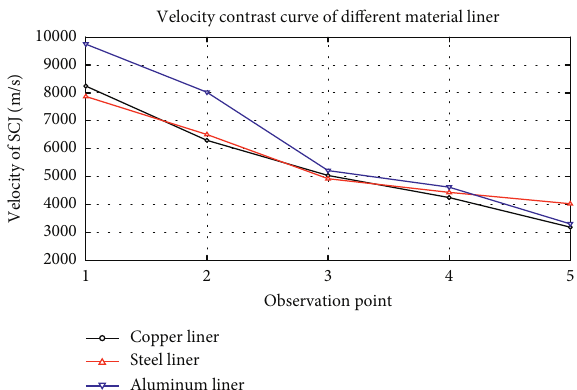
Figure 12: Velocity comparison of three kinds of material